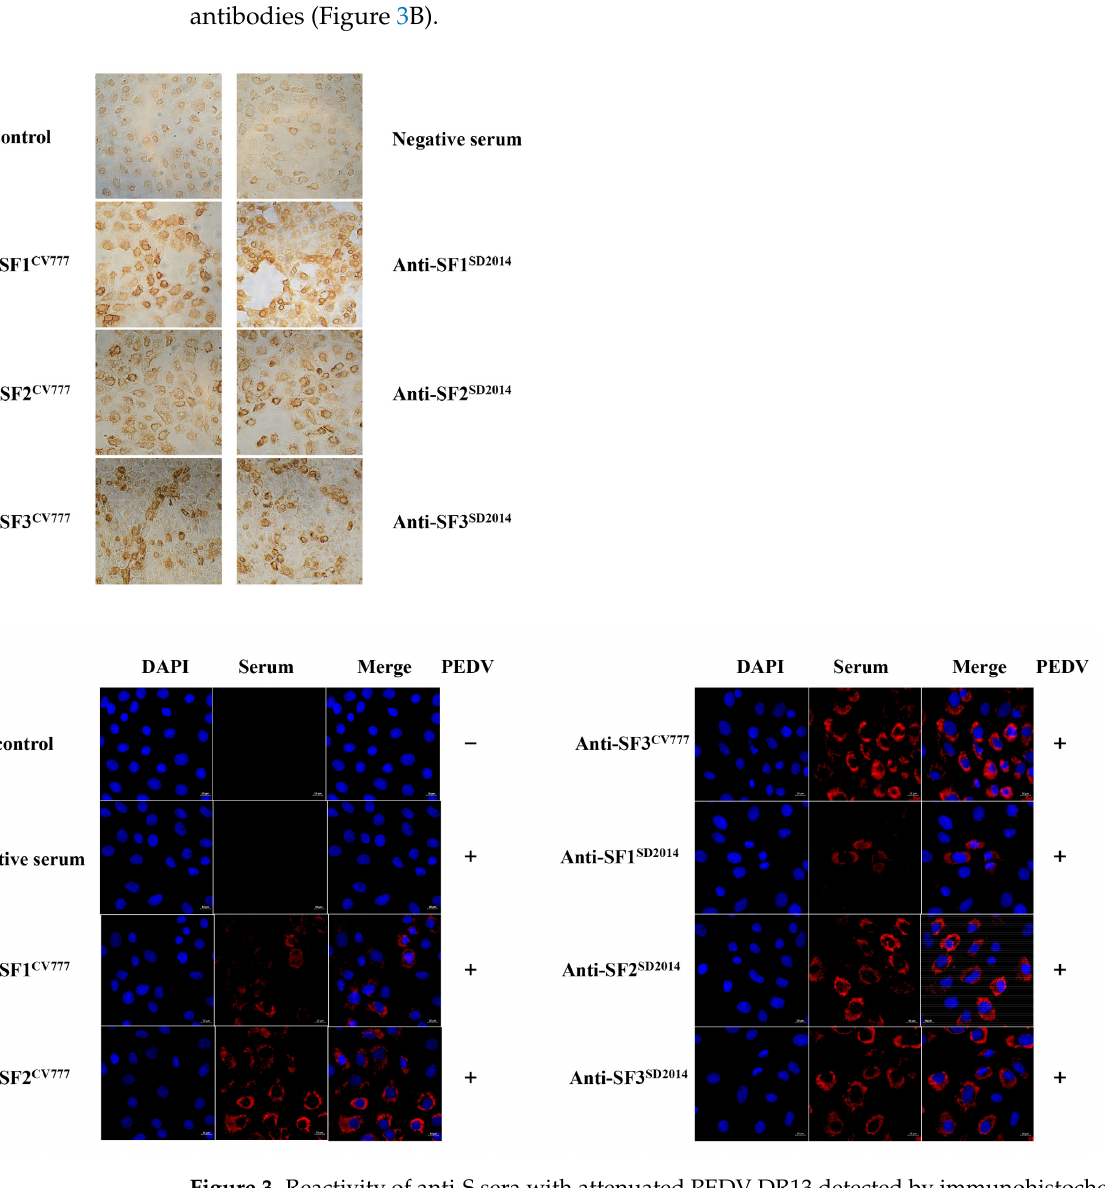
Figure 3. Reactivity of anti-S sera with attenuated PEDV DR13 detected by immunohistochemistry assay (IHC) ( A ) and immunofluorescence assay (IFA) ( B ). Cells were infected with PEDV DR13 at multiplicities of infection (MOI) of 0.1, and at 18 h postinfection (h.p.i.), cells were fixed and stained with anti-S sera. For IHC, Horseradish Peroxidase (HRP)-labeled goat anti-rabbit IgG was used as the secondary antibody. Then cells were incubated with diaminobenzidine before visualization with a light microscope. For IFA, Alexa Flur 647 goat anti-rabbit IgG (H + L) was used as the secondary antibody, and 4’,6-diamidino-2’-phenylindole (DAPI) was used to visualize the cell